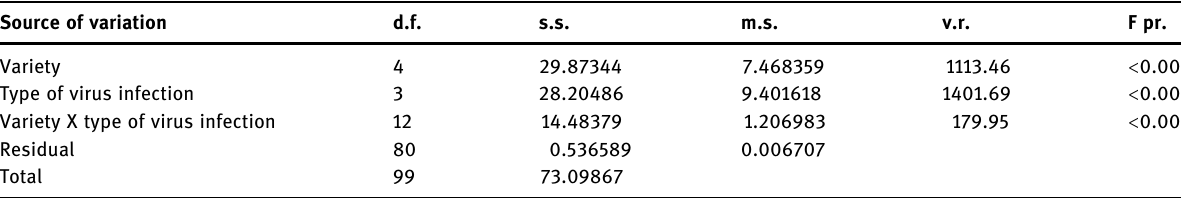
Table 1: ANOVA table for rAUDPC values for fi ve varieties and types of virus infection Source of variation